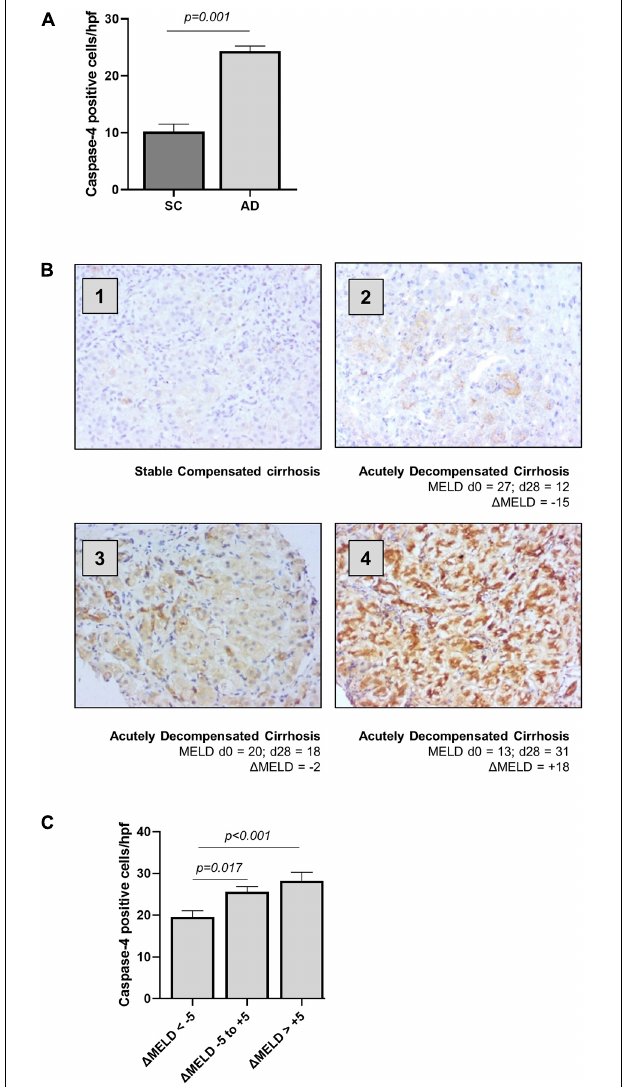
FIGURE 1 | Hepatic caspase-4 expression correlates with the severity of liver disease. The expression of caspase-4 in the liver was measured by immunohistochemistry and quantified as number of positive cells/high power field. (A) Patients with acutely decompensated cirrhosis were found to have elevated expression of caspase-4 in the liver compared to patients with stable, compensated cirrhosis (Mann-Whitney U test, p < 0.001). (B) Patients were divided into three categories, based on (cid:49) MELD score (MELD d28 – MELD d0): ‘Improved’ patients with (cid:49) MELD below –5, “stable” with (cid:49) MELD between –5 and + 5, and “worsened” with an increase in MELD score greater than + 5 points. Panels 1–4 show representative caspase-4 staining for (1) stable cirrhosis (SC), (2) ‘improved’ AD, (3) “stable” AD, and (4) “worsened” AD. (C) Caspase-4 expression in the liver was significantly different among the three groups (Kruskal-Wallis test p < 0.001), being significantly higher in “stable” and “worsened” groups, compared to ‘improved’ patients (Dunn’s test, p = 0.017 and p < 0.001